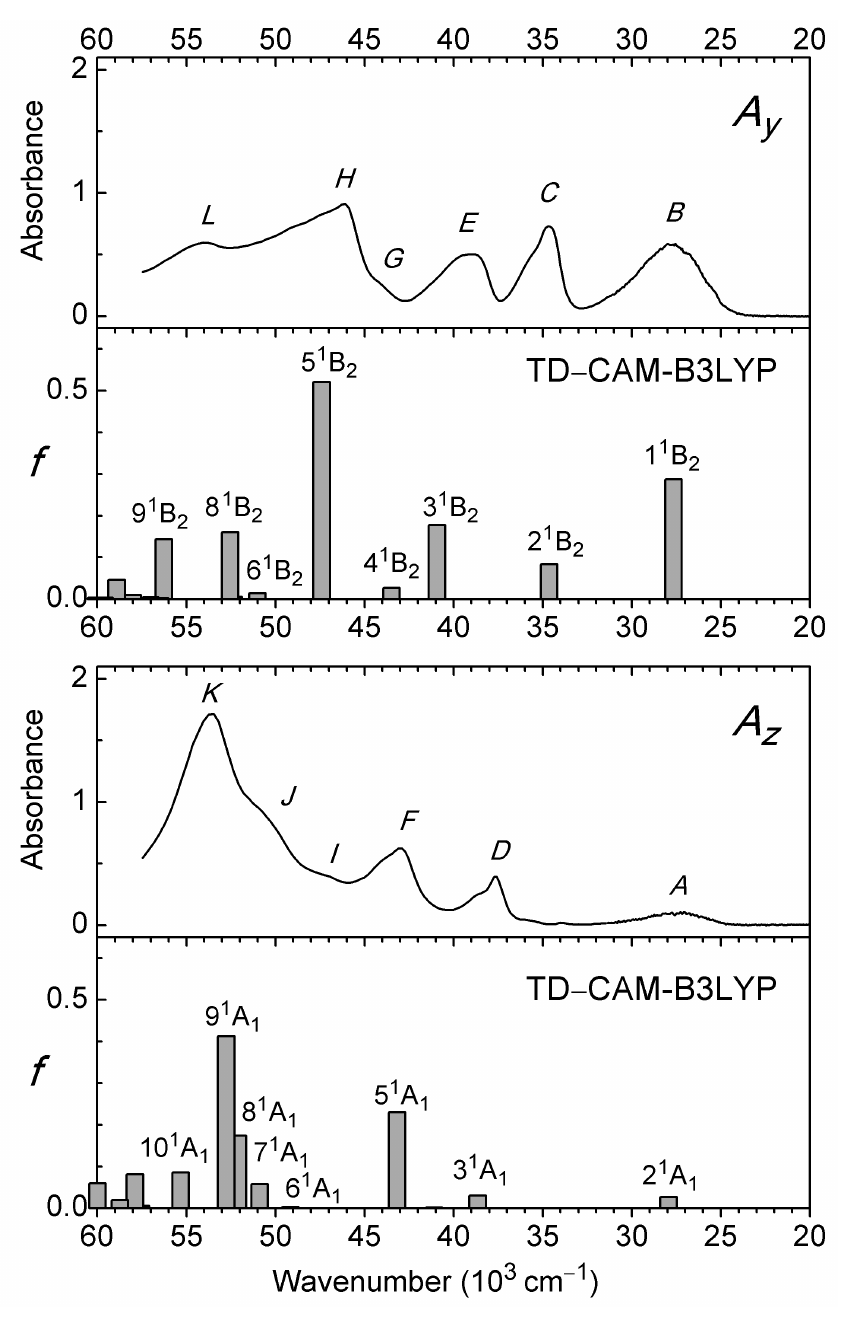
Figure 3 Partial absorbance curves A y and A z for anthralin (A) and electronic transitions to excited 1 B 1 A 2 and 1 states predicted with TD–CAM-B3LYP/aug-cc-pVTZ.